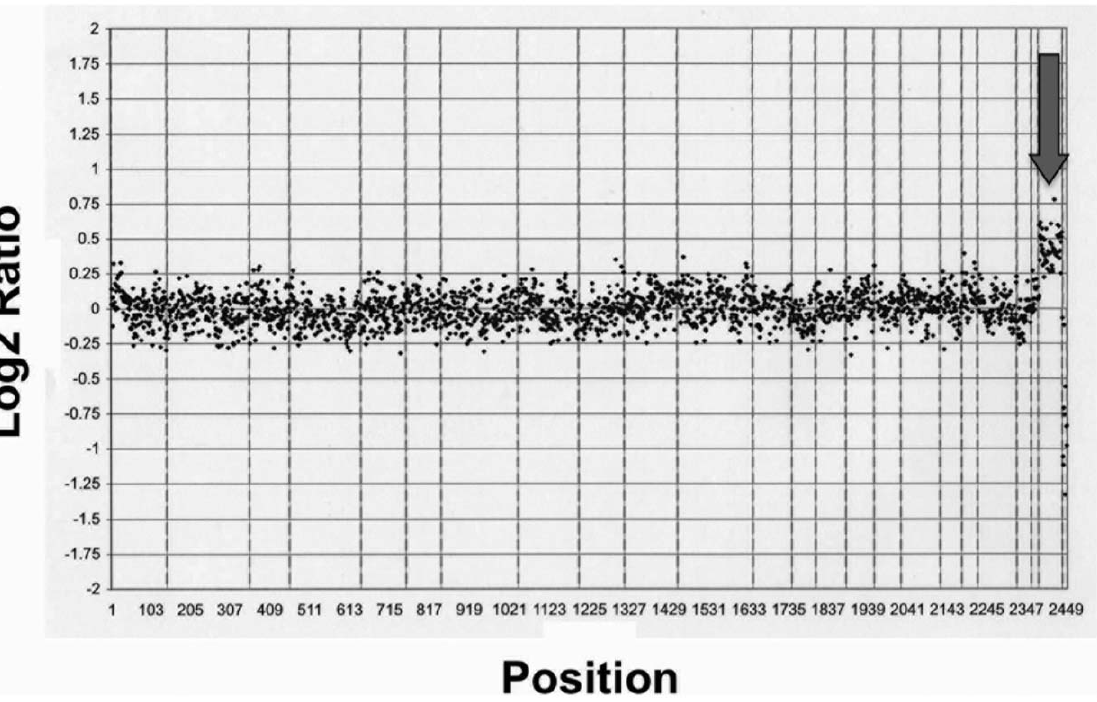
Figure 4. The a MHC-GFP reporter line maintains genomic integrity. a MHC-GFP hESCs (H9; 46,XX) passaged ten times after stable selection were analyzed by array comparative genomic hybridization. The log 2 ratios for all loci on the array were plotted in genome order from chromosome 1pter to Xqter. The data were normalized so that the log 2 ratio=0 for genomic regions that are present in diploid copy number. Male reference DNA was used in the hybridization as indicated by the sex mismatch for chromosome X (arrow). There was no evidence of copy loss or gain, consistent with maintenance of euploidy.